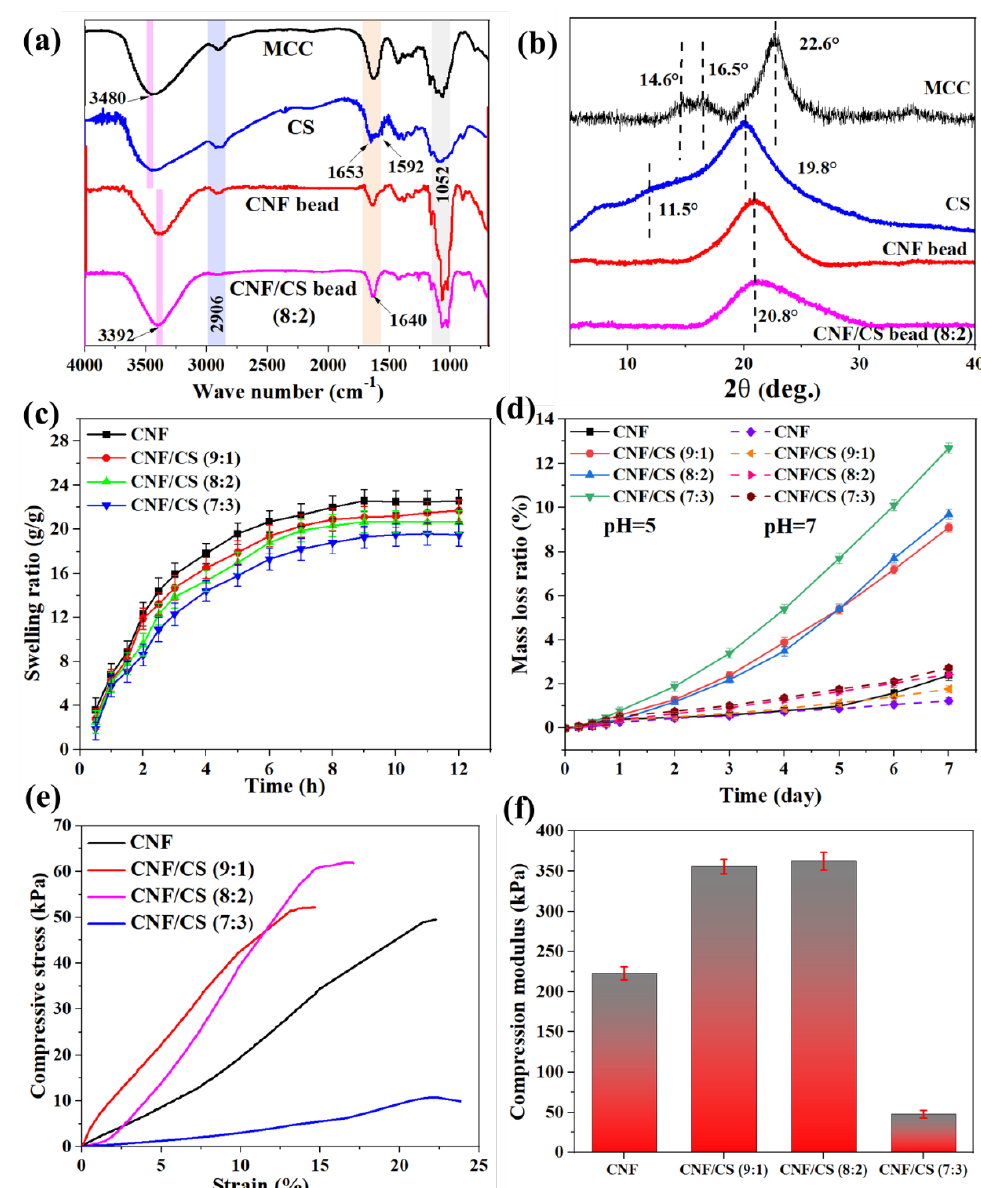
Figure 3. FTIR spectra ( a ) and XRD patterns ( b ) of raw materials and the obtained beads; Swelling ratio ( c ) and mass loss ratio ( d ) of CNF and CNF/CS beads; Compressive stress ( e ) and compression modulus ( f ) of CNF and CNF/CS beads.